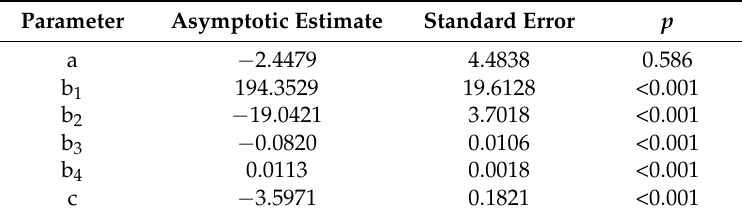
Table 5. Parameter asymptotic estimates and their standard error and p for the stand yield loss equation based on competing vegetation biomass (V), average annual rainfall (R) and intensity of competing vegetation control (X).